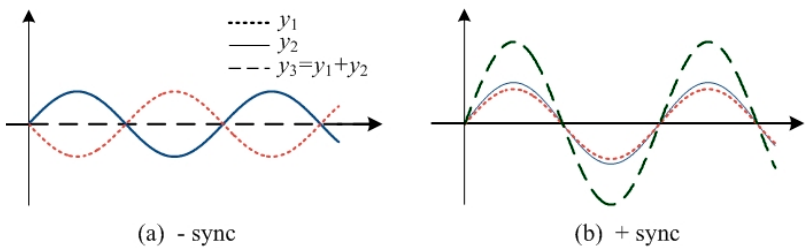
Figure 1. Sync of signal. ( a ) –sync; and ( b ) +sync.